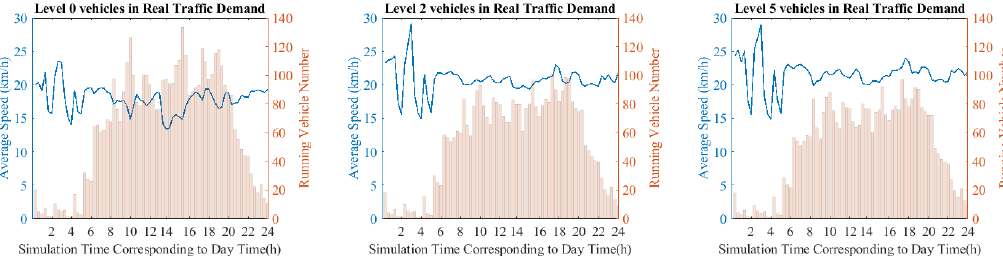
Figure 7. Average speeds of vehicles and running vehicle numbers of simulations with vehicles of different automation levels.